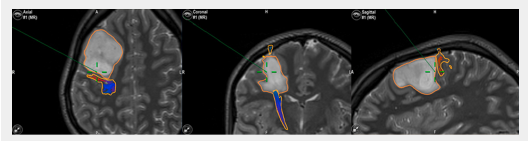
Neuronavigation allows correlation of any intra-operative point with the pre-operative MRI. Intraoperative neuronavigation facilitates spatial orientation during surgery at the crucial interface between a low-grade glioma (hyper- intense), the primary motor cortex (red) and the corticospinal tract (blue).